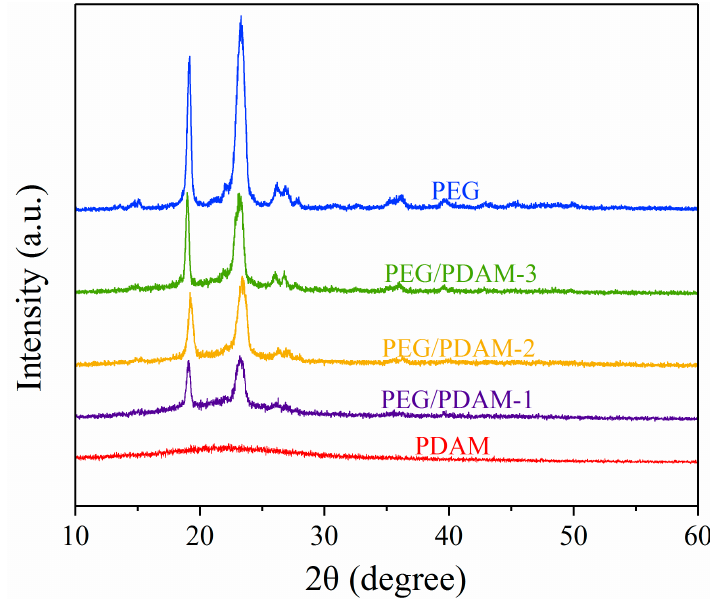
Figure 5. XRD patterns of PEG, PEG/PDAM-1, PEG/PDAM-2, PEG/PDAM-3, and PDAMs.